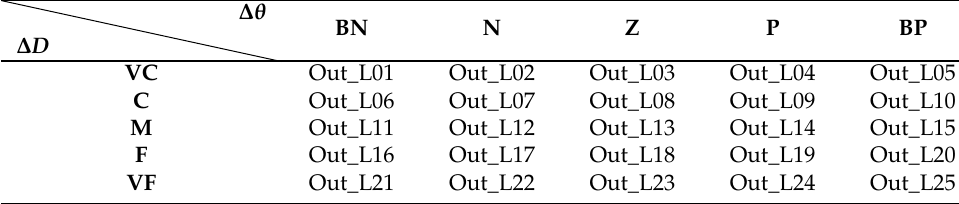
Table 5. The rules of the left wheel angular